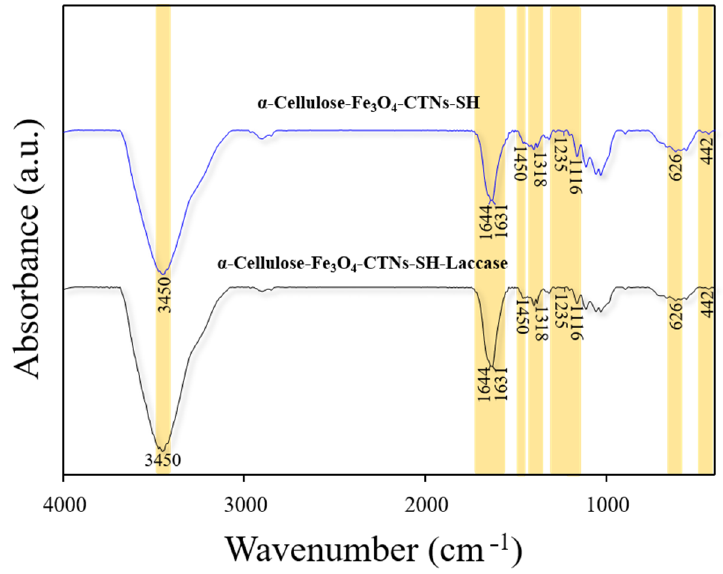
Figure 6. FT-IR analysis of the α -Cellulose-Fe 3 O 4 -CTN-SH and α -Cellulose-Fe 3 O 4 -CTN-SH-Lac- case.